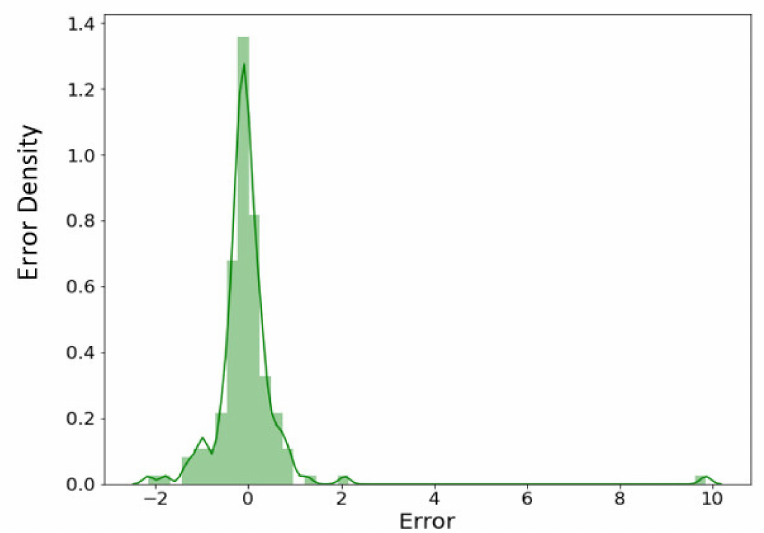
Figure 11. Error density analysis of the predicted